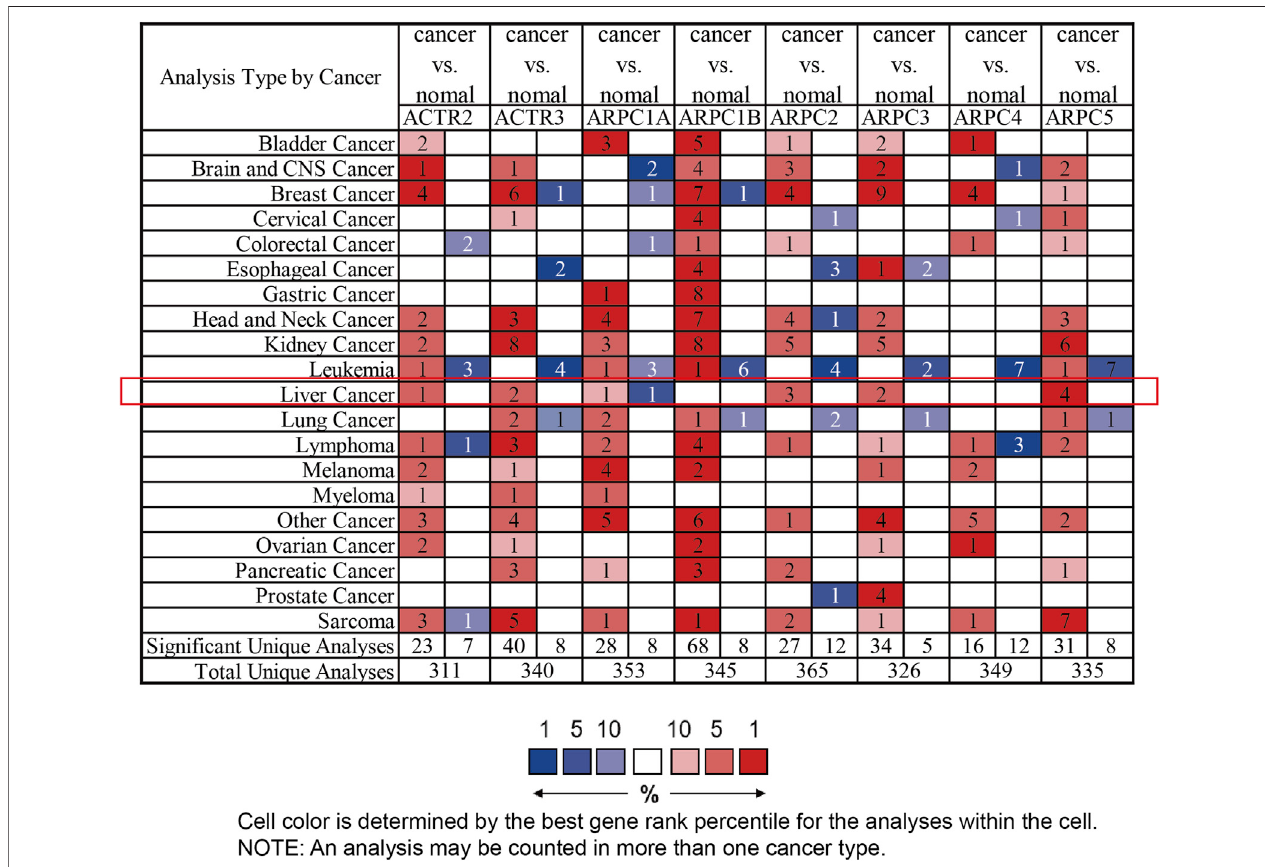
FIGURE 1 | mRNA expression level of Arp2/3 complex members in different types of cancer from multiple datasets (the Oncomine database). Difference of transcriptionalexpressionwascomparedusingStudent ’ s t -testandcutoffofparameters: p -value < 0.0001,foldchange (cid:1) 1.5,andgenerank (cid:1) 10%.Theredcolorinthe cell represents overexpression, and green represents down-expression. The number in each cell presents the amount of